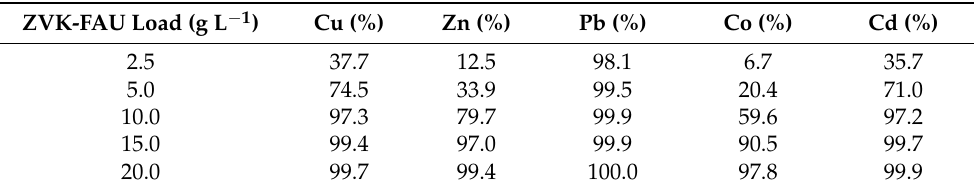
Table 3. Effect of FAU zeolite from VK (ZVK-FAU) loading variation ( C 0 = 300 mg L − 1 at 90 min) on the percentage removal (%) of divalent